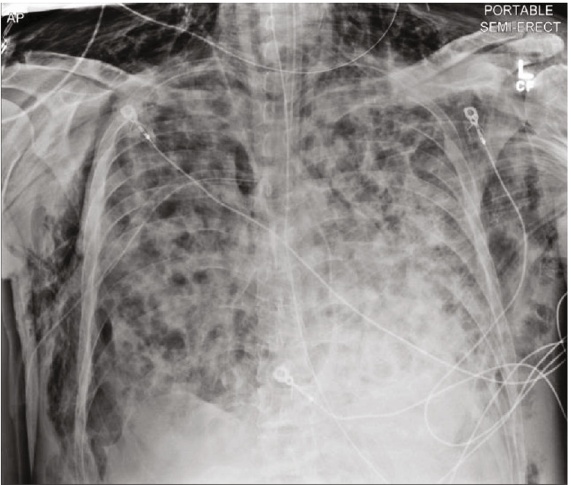
Figure 4: Panthoracic subcutaneous emphysema with single chest tube in place s/p resolution of recurrent